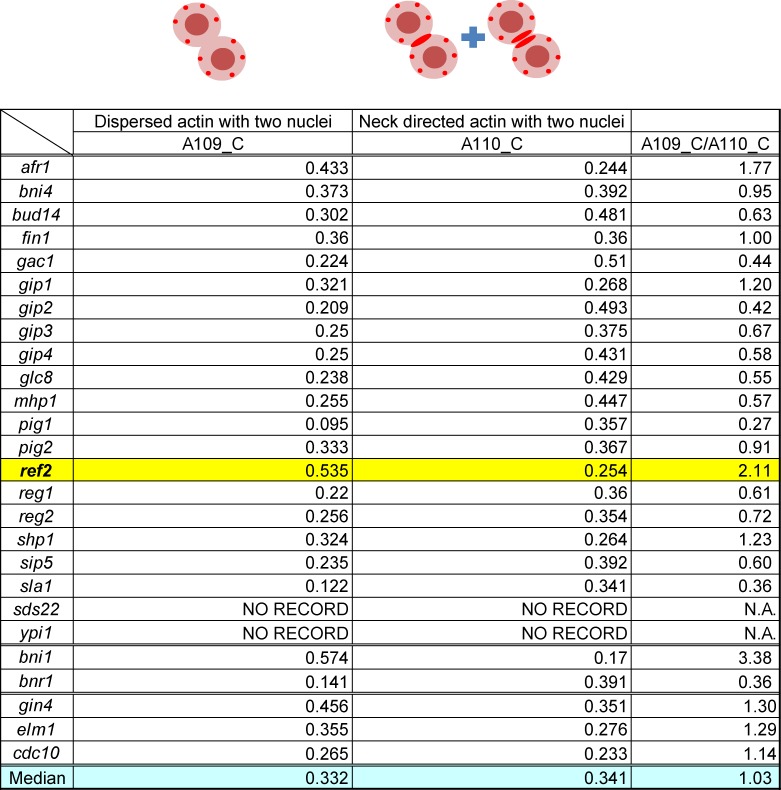
In silico screening identifies PP1 regulatory subunit Ref2 as a potential cytokinesis regulator.Saccharomyces cerevisiae morphological database [21] was used for in silico screening. We focused on two parameters, dispersed actin with divided nuclei (A109_C) and directed actin at the bud neck with divided nuclei (A110_C). Median of all mutant strains analyzed in the database were shown as a control value. Deletion mutants for Glc7 regulatory subunits (from afr1Δ to ypi1Δ), formins (bni1Δ and bnr1Δ) septin related kinases (gin4Δ and elm1Δ) and a septin (cdc10Δ) were analyzed. N.A., not assigned.